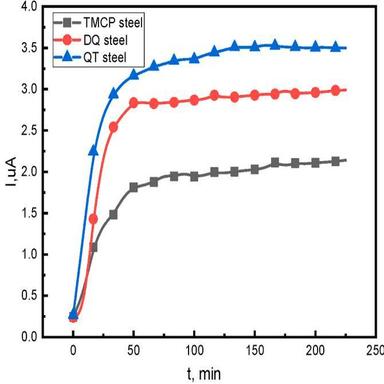
Hydrogen permeation curves of Ni-advanced steels prepared using different processes.